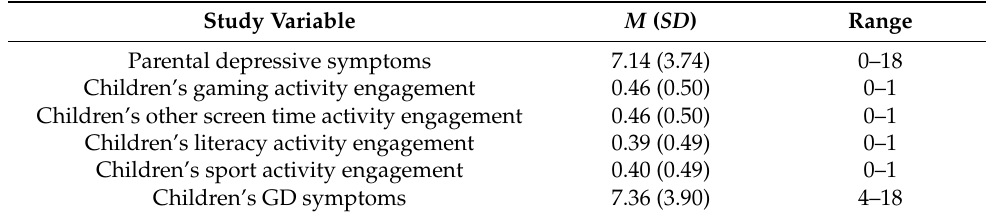
Table 3. Descriptive statistics of study variables ( n =